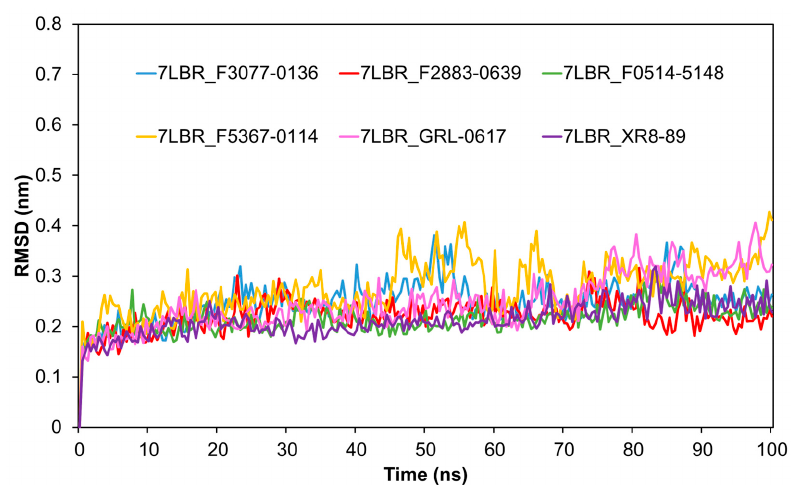
Figure 2. The comparison of the proteins’ RMSD values. The blue, red, green, yellow, pink, and purple lines represent the RMSD values for 7LBR after binding to F3077-0136, F2883-0639, F0514-5148, F5367-0114 (negative control), GRL-0617 (drug candidate from a previous study), and the cocrystal structure 7LBR_XR8-89,